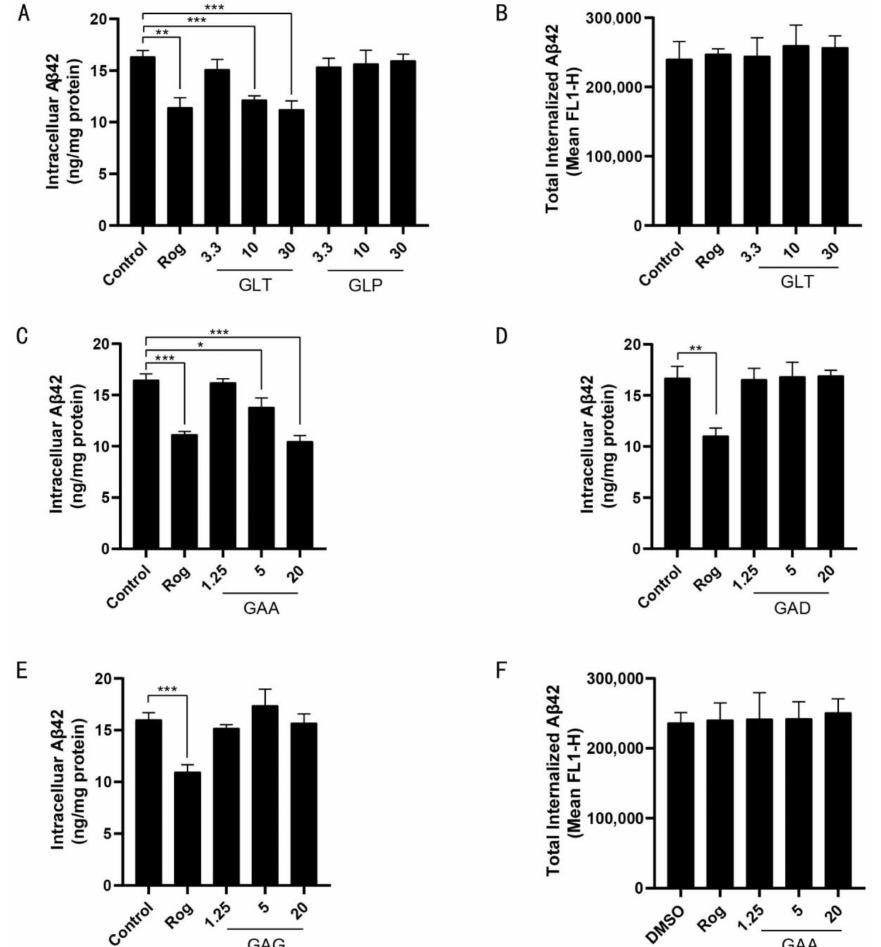
Figure 1. GAA facilitates A β 42 degradation in microglial cells. ( A ) BV2 cells were treated with Rog (10 µ M), GLT, and GLP at the indicated concentrations in the presence of A β 42 (2 µ M) for 24 h, and intracellular A β 42 levels were measured using ELISA. Rog vs. Control: p = 0.0016; GLT-10 vs. Control: p =0.0005; GLT-30 vs. Control: p = 0.001; n = 3. ( B ) A β 42 uptake by BV2 was assessed by applying FITC-labeled A β 42 (1 µ M) to BV2 cells in the presence of Rog (10 µ M) and GLT at the indicated concentrations for 24 h. Accumulation of the fluorophore was analyzed by flow